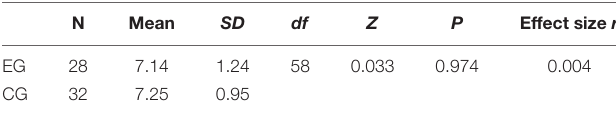
TABLE 4 | Mann-Whitney U -test of immediate post-test in the EG and the CG.